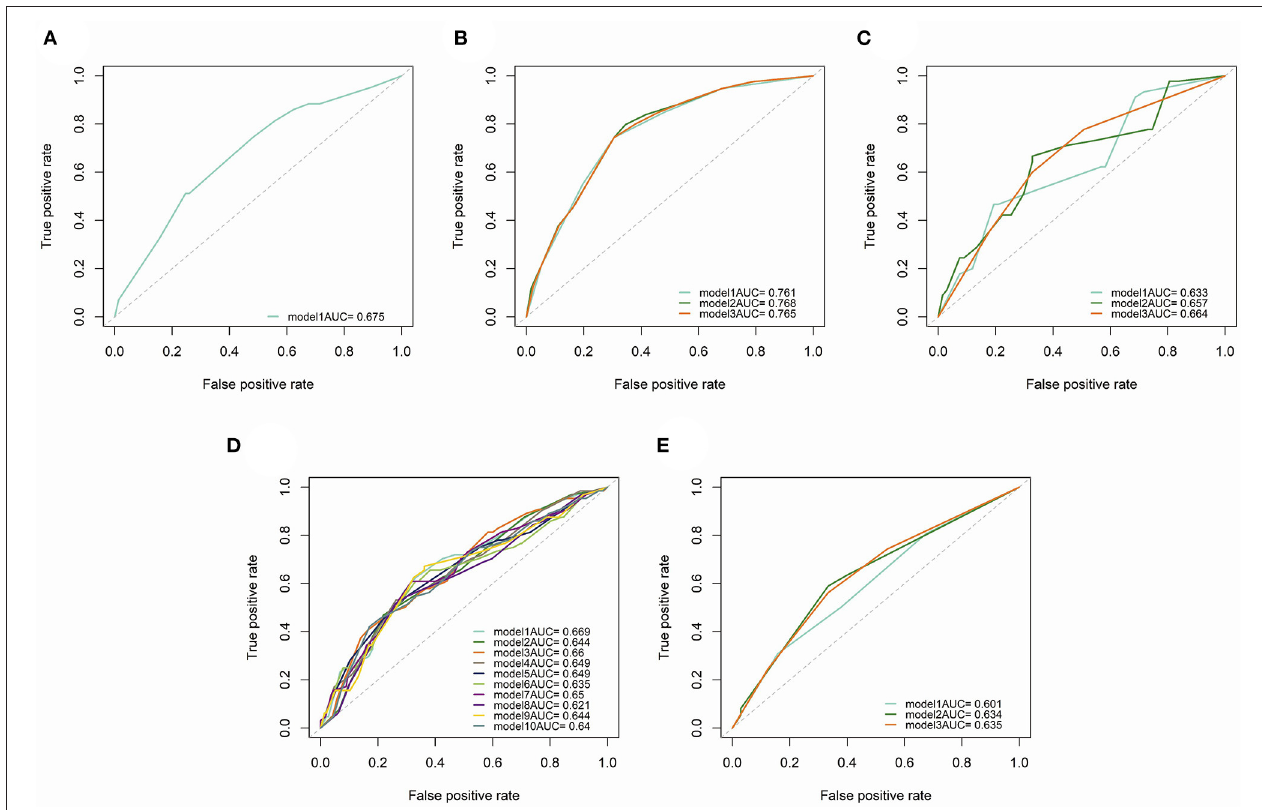
FIGURE 7 | Time-dependent (3-year) ROC curves and AUC of different prognostic models in subgroup analysis. (A) patients underwent sublobectomy. (B) patients underwent lobectomy. (C) patients underwent extended lobectomy. (D) patients in stage I. (E) , patients in stage II.